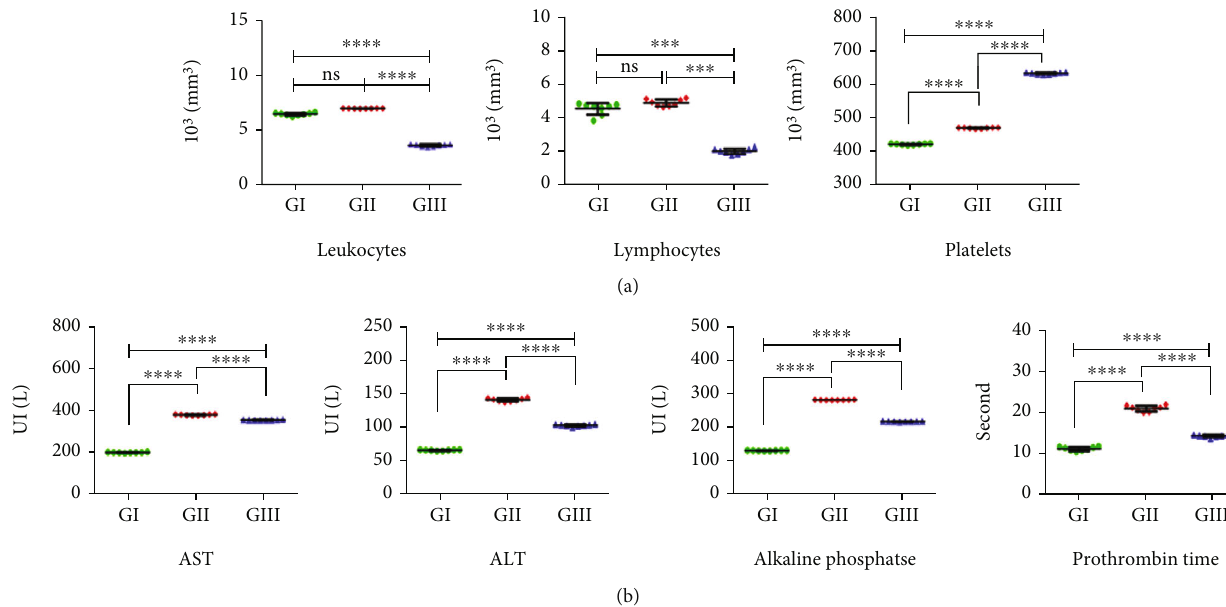
Figure 7: E ff ect of TAA on blood cells and on liver function. Comparative studies between blood count (a) and analytes values (b) of rats with chronic liver fi brosis, no treatment groups (GI and GII), and chronic liver fi brosis treated with ASCs (GIII). Data values are the mean ± SD . Representation of signi fi cant di ff erence: ∗∗∗∗ is considered p < 0 : 001 ; ∗∗∗∗ is p < 0 : 0001 , and ns=no signi fi cant di ff